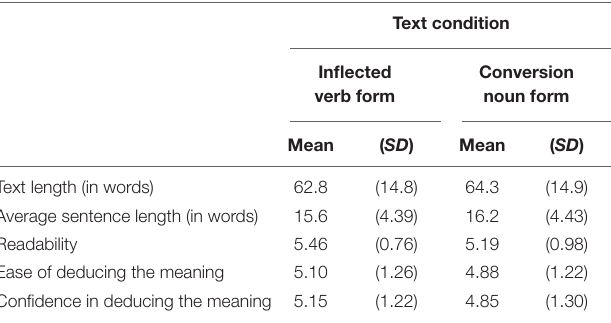
TABLE 2 | Properties of texts introducing the novel